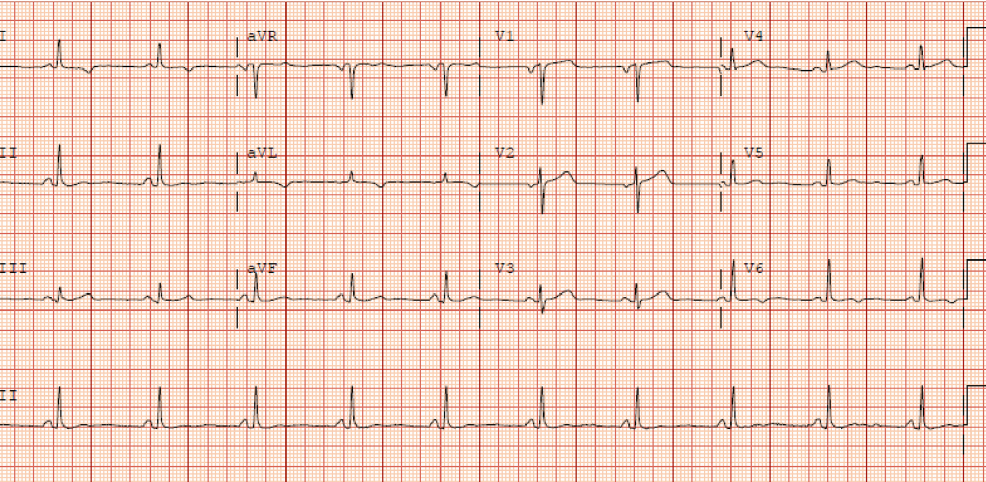
Figure 3: 12-lead electrocardiogram obtained 3 weeks after hospital discharge showing return of PR and ST segments to